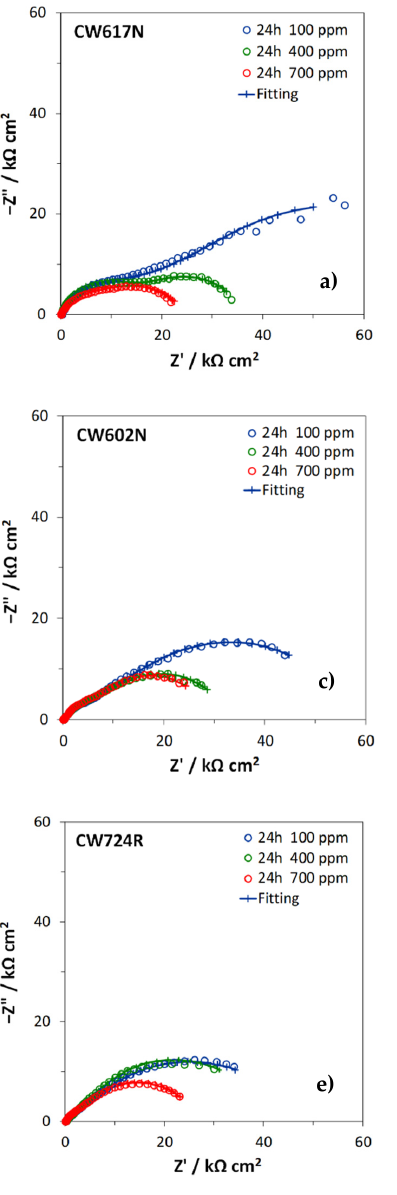
Figure 6. EIS spectra recorded on CW617N ( a , b ), CW602N ( c , d ), and CW724R ( e , f ) after 24 h immersion in SDW solutions, at the three different chloride concentrations.